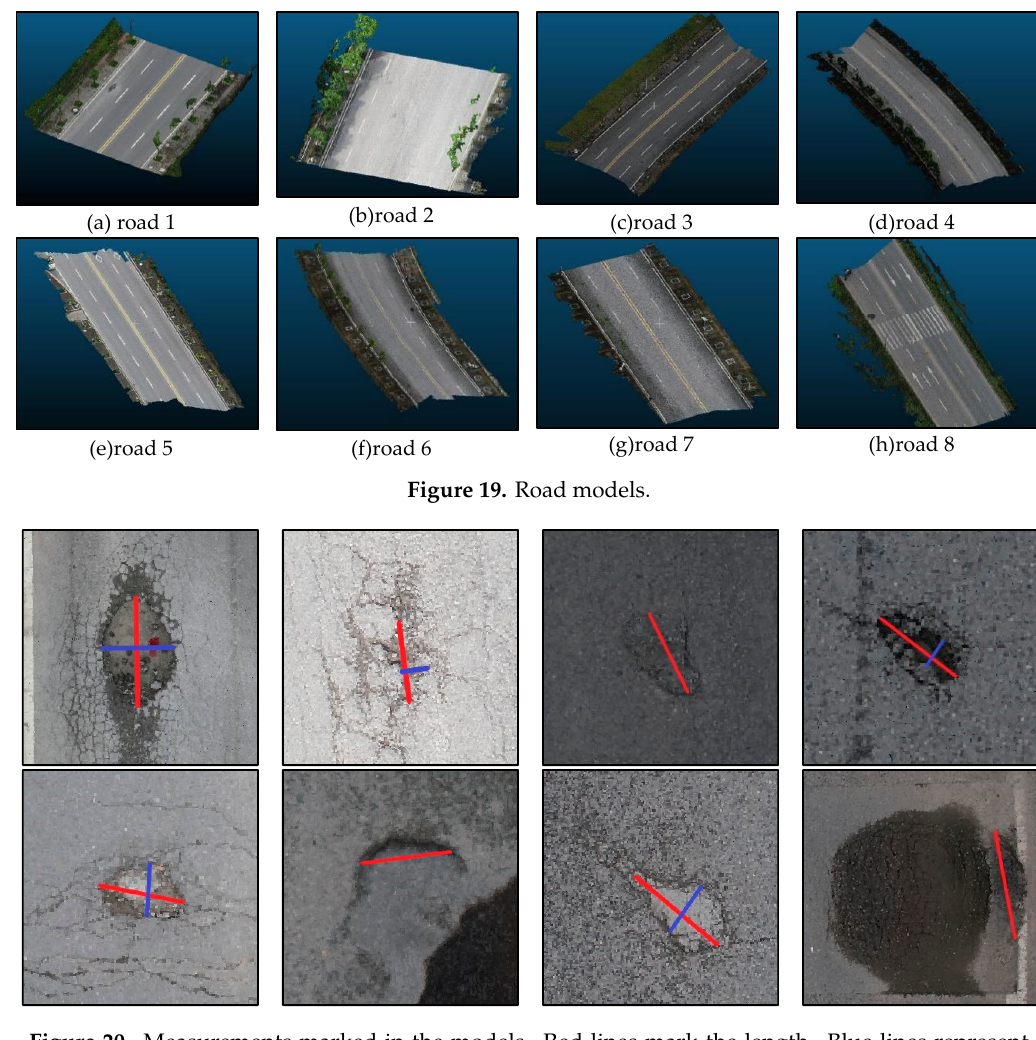
Figure 20. Measurements marked in the models. Red lines mark the length. Blue lines represent the width. Note that not all dimensions were collected, and only the collected measurements are marked above.